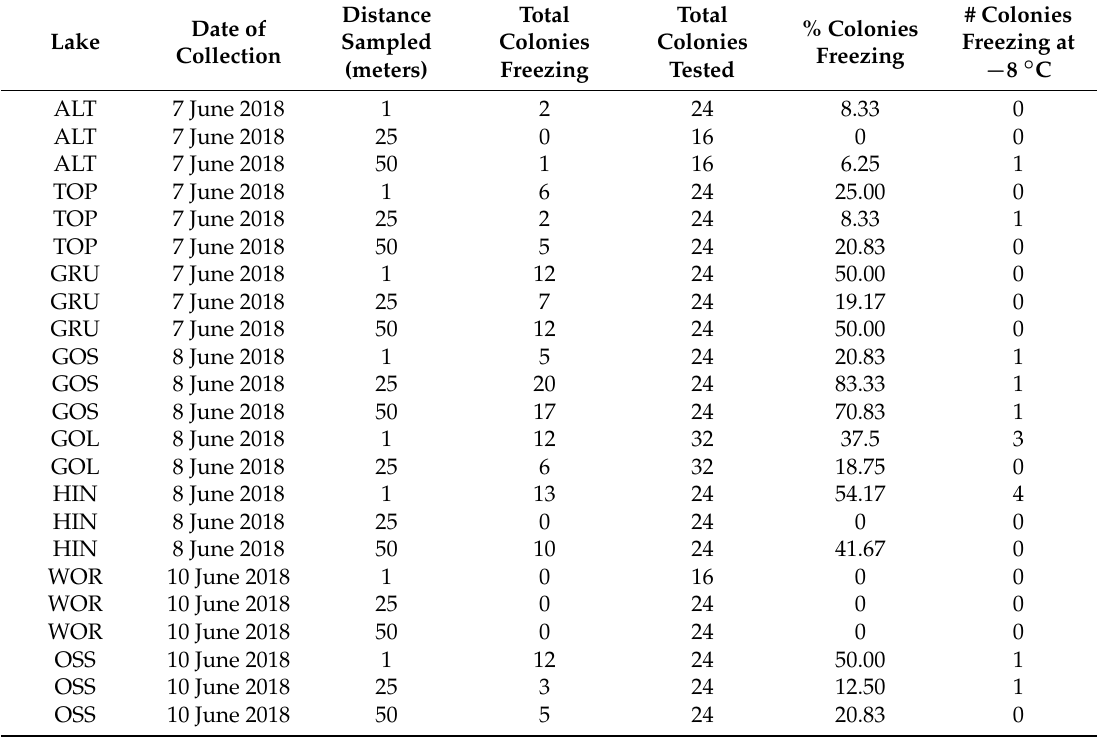
Table 2. Results from the ice nucleation assays for strains of Pseudomonas -like colonies cultured on KBC.